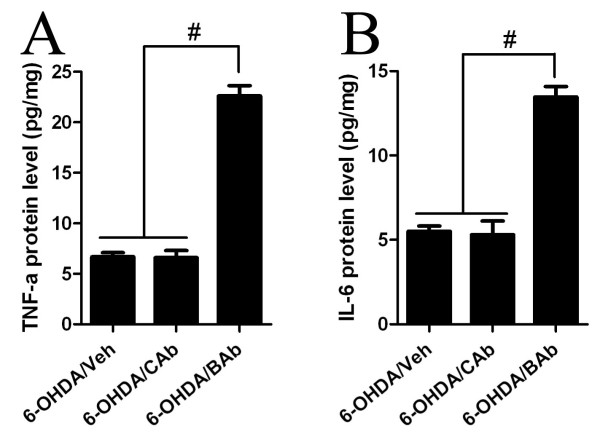
BAb regulates pro-inflammatory factor production in SN. Concentrations of TNF-α and IL-6 in SN were assayed using ELISA at 21 days post-6-OHDA injection. Values are shown as mean ± S.E.M. The concentrations of cytokines in the 6-OHDA/BAb co-treated group were significantly higher than those in the other groups. There was no significant difference between the 6-OHDA/CAb- and the 6-OHDA/Veh-treated groups. Data are representative of three individual experiments. # P < 0.001, significant difference compared to every other group.